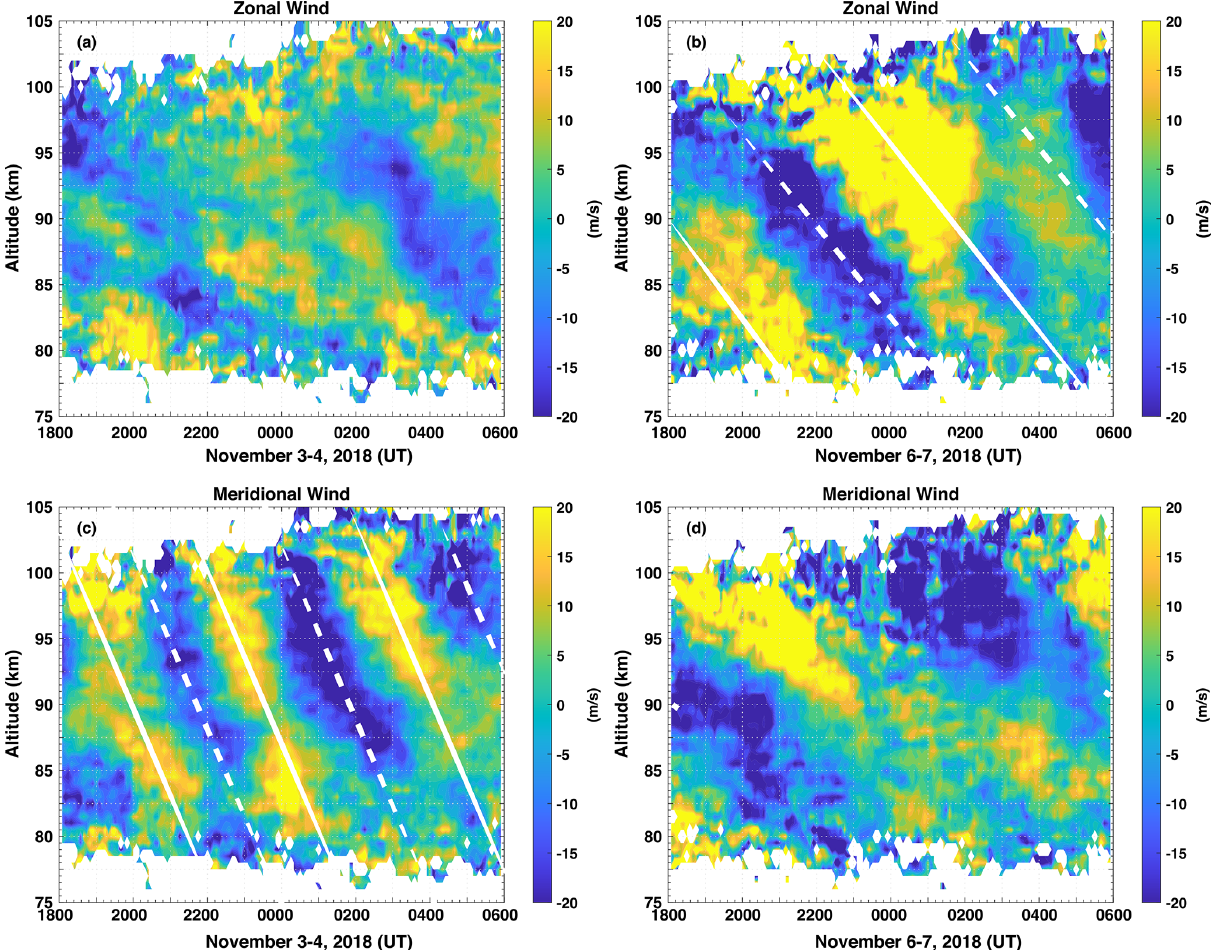
Figure 10. Time–altitude cross section of the zonal and meridional wind fluctuations for the nights of 3–4 and 6–7 November 2018. The continuous (dashed) white lines indicate crests (troughs) of the oscillations as well as the descending phase (ascending energy propagation) of the waves. Note the coherent τ o ∼ 4.3h gravity wave oscillation on 3–4 November with λ z ∼ 25.6km. The zonal wind oscillation on 6–7 November corresponds to a λ z ∼ 21.3km, τ o ∼ 8.0h gravity